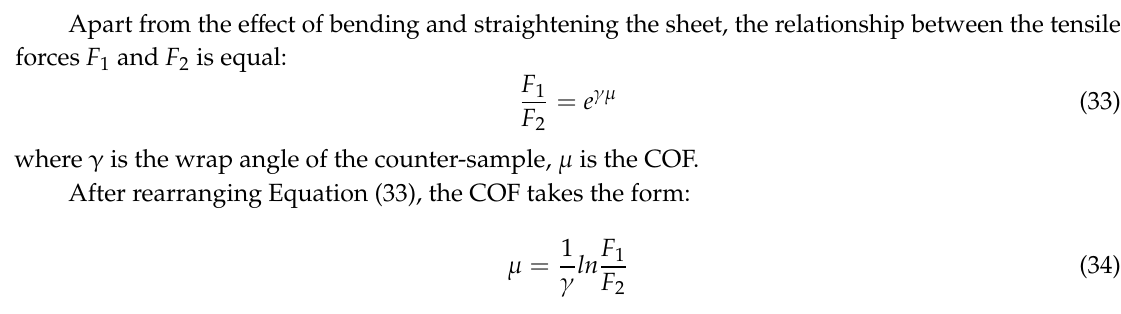
Figure 27. Schematic diagram of the OSU friction test: F 1 —the force acting on the center of the specimen, F 2 —is the force acting in side walls, H —punch height, N —pressure force, R —radius of cylindrical counter-sample, γ is the contact angle, ε 1 and ε 2 —strains of the specimen in the center and side walls,